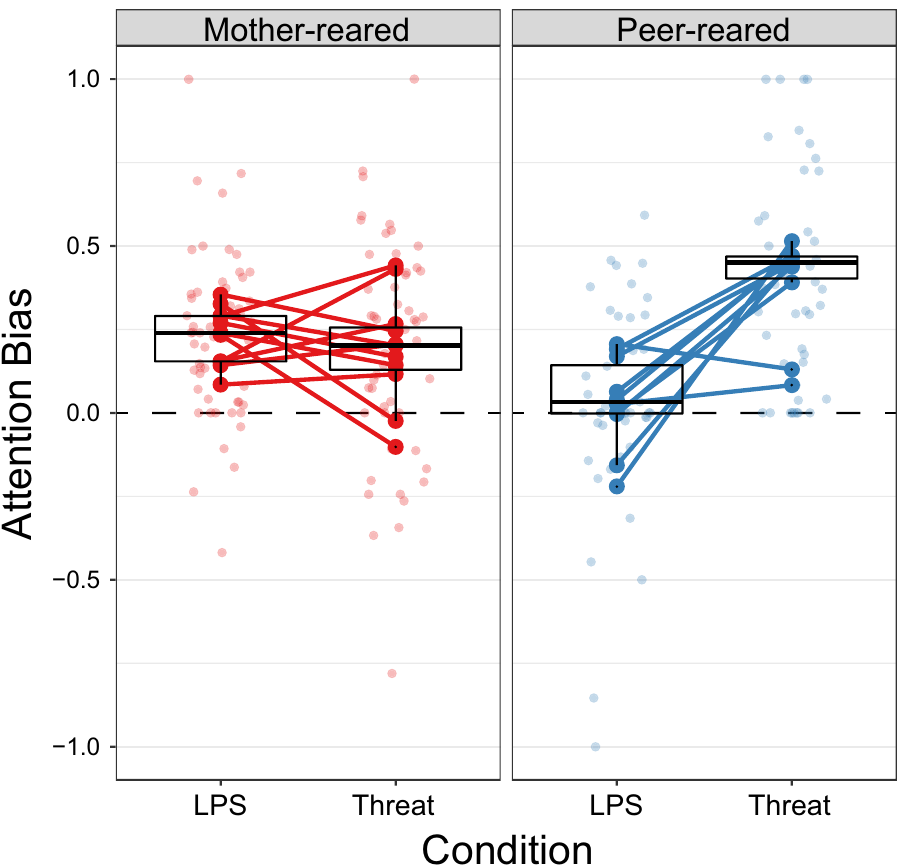
Figure 2. Attention biases in the Neutral-LPS and Neutral-threat conditions, for the mother-reared group (red; left) and peer-reared group (blue; right). Zero indicates no bias, positive values a bias towards LPS or threat versus neutral, and negative values a bias towards neutral versus LPS or threat. Light-coloured dots represent the bias in each trial, large dark-coloured dots indicate the average bias for each subject, and lines connect the average bias in the two conditions per subject. The median bias per group, first and third quartiles, and + or − 1.5 times the inter-quartile range from the first and third quartiles are also shown in the box